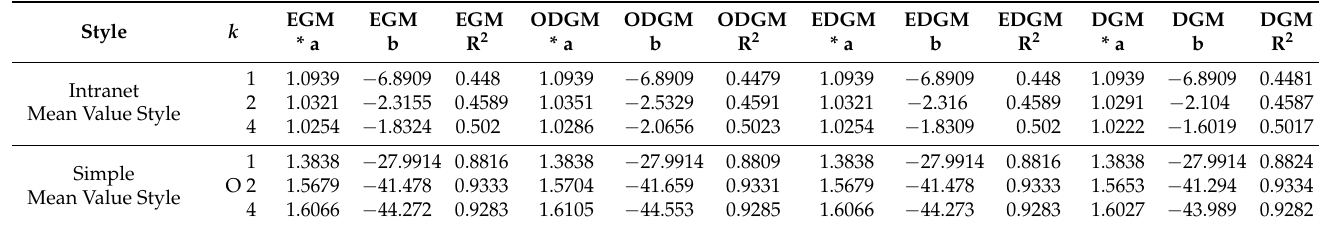
Table 2. Linear relation between RV and FV of coal consumption percentage.